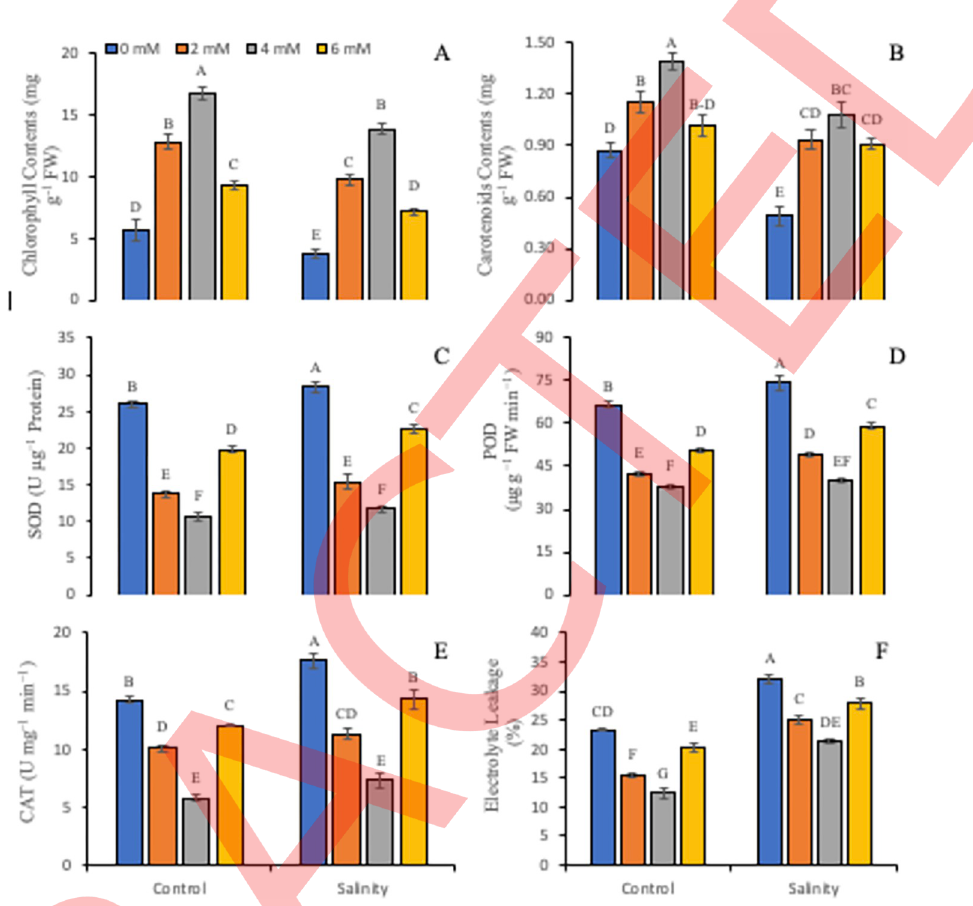
Fig 4. Biochemical and enzymatic antioxidants attributes A) chlorophyll contents; B) carotenoid contents; C) SOD activity; D) POD activity; E) catalase activity and F) electrolyte leakage of spinach at harvesting stage in response to silicon (0, 2, 4, 6 mM) and salinity (150 mM NaCl) applications. For each parameter, mean data ( ± SD, n = 3) with different letters indicate a significant difference ( P < 0.05).